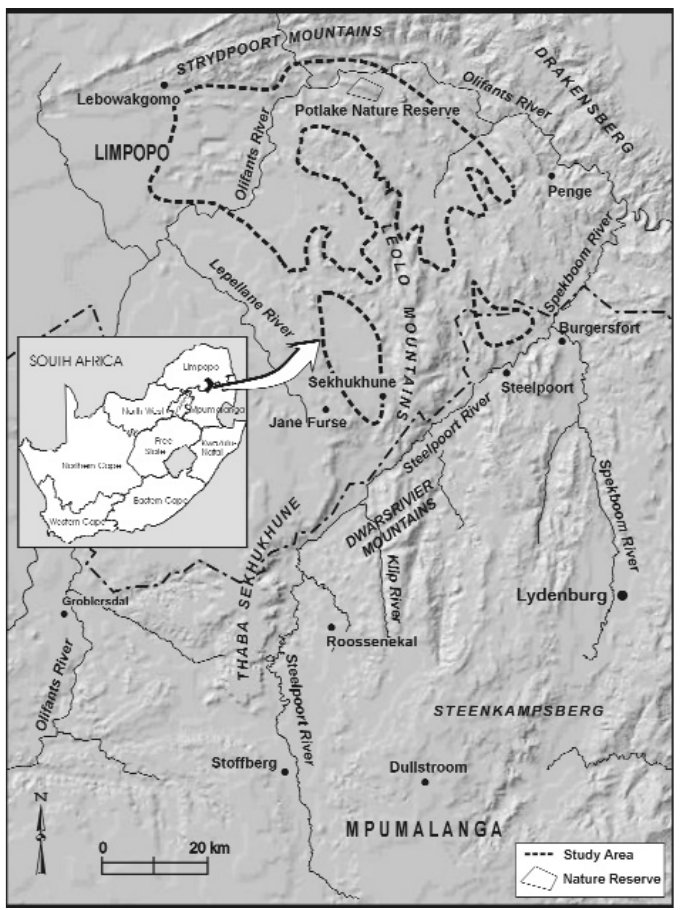
Fig. 1. Location of the semi-arid savanna of the Sekhukhuneland Centre in the Limpopo